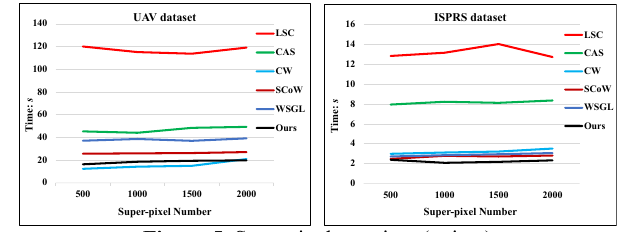
Figure 5 . Superpixels runtime (unit: s)